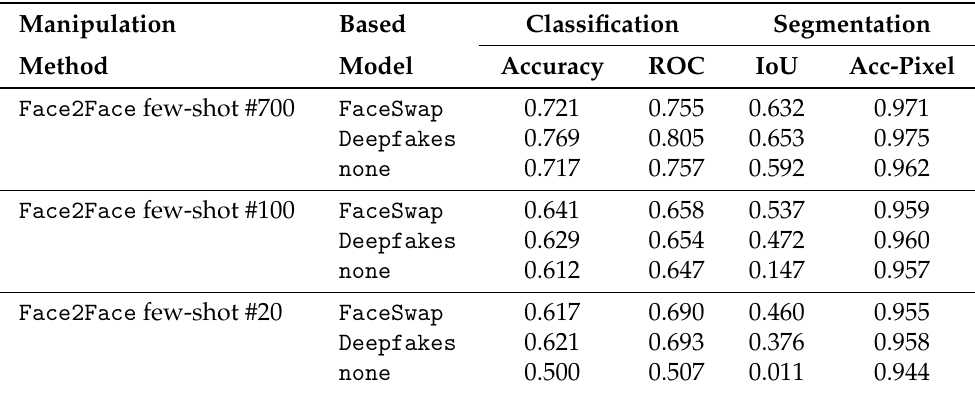
Table 5. Results for few-shot learning of detecting C23 crop images altered by Face2Face manipula- tion methods with difference-based models. In this table, acc-pixel stands for pixel-wise